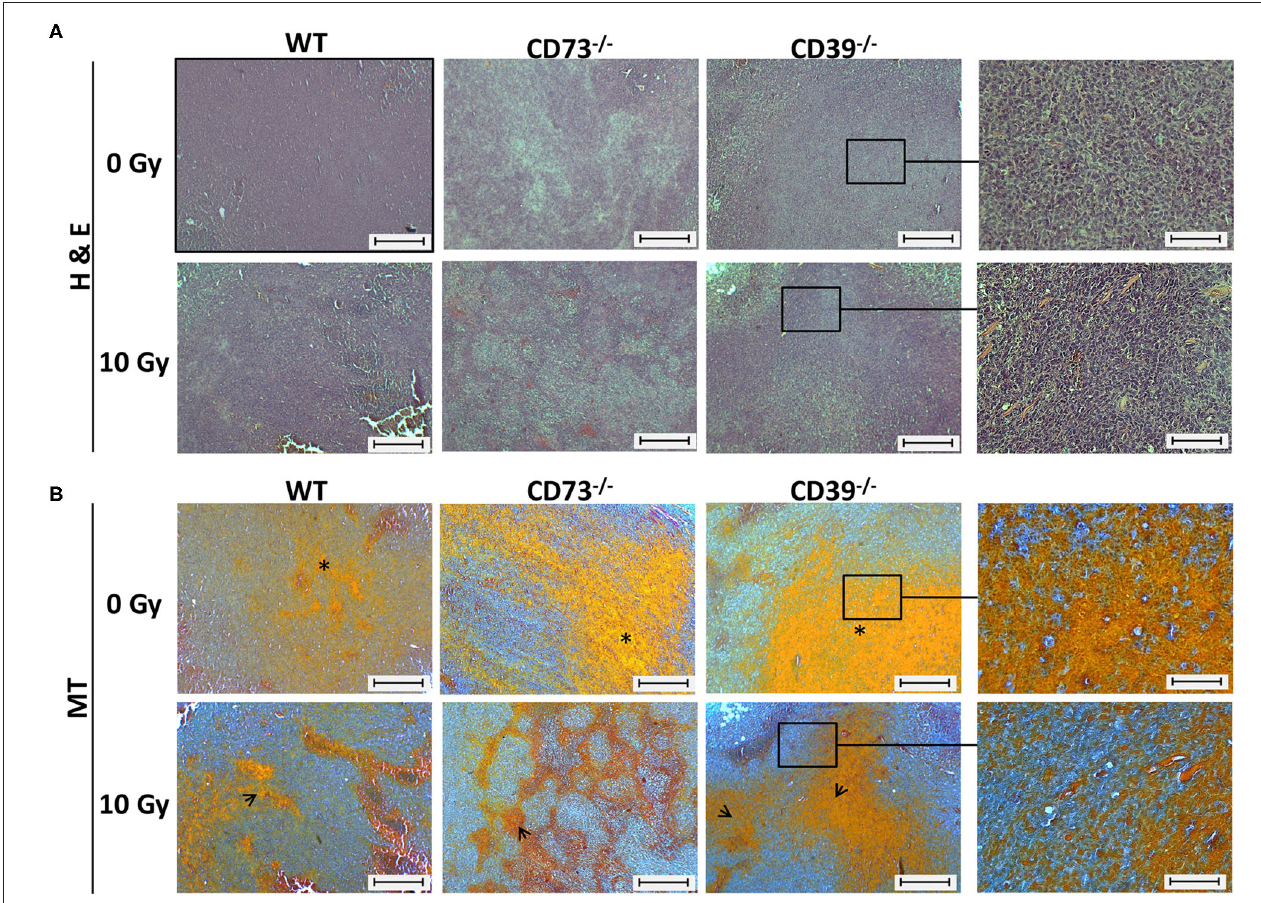
FIGURE 5 | Host CD39 deficiency causes a reduced regressive phenotype of irradiated tumors. LC1 tumor cells (0.5 × 10 6 cells each) were subcutaneously transplanted onto the hindlimb of C57BL/6 wild-type and CD39- and CD73-deficient [knockout ( − / − )] mice. Hind-leg single-dose irradiation with 0 or 10Gy was conducted at the timepoint of tumor manifestation. Mice were sacrificed at the timepoint of maximal tumor volume (1,000 mm 3 ). (A) Hematoxylin-eosin (H&E) or (B) Masson Goldner trichrome (MT) staining of paraffin-embedded LLC1 tumor tissue, scale bar 100 µ m. Magnified pictures (400-fold) highlight special structures. n = 15/17 (C57BL/6), 17/13 (CD39 − / − ), 7/13 (CD73 − / − ). Asterisks and open arrows indicate areas of a higher degree of epithelial structures (orange colored).